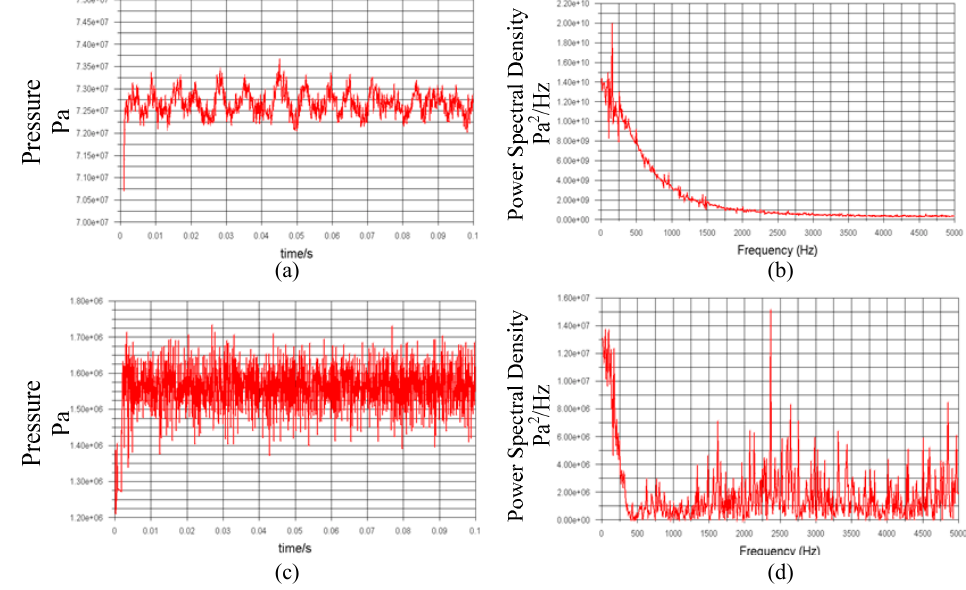
Figure 27. Pressure oscillation curve of the flapper under the influence of the main valve when the displacement of the flapper is x = 0.15 mm. ( a ) Point 1 in the time domain. ( b ) Point 1 in the frequency domain. ( c ) Point 2 in the time domain. ( d ) Point 2 in the frequency domain.